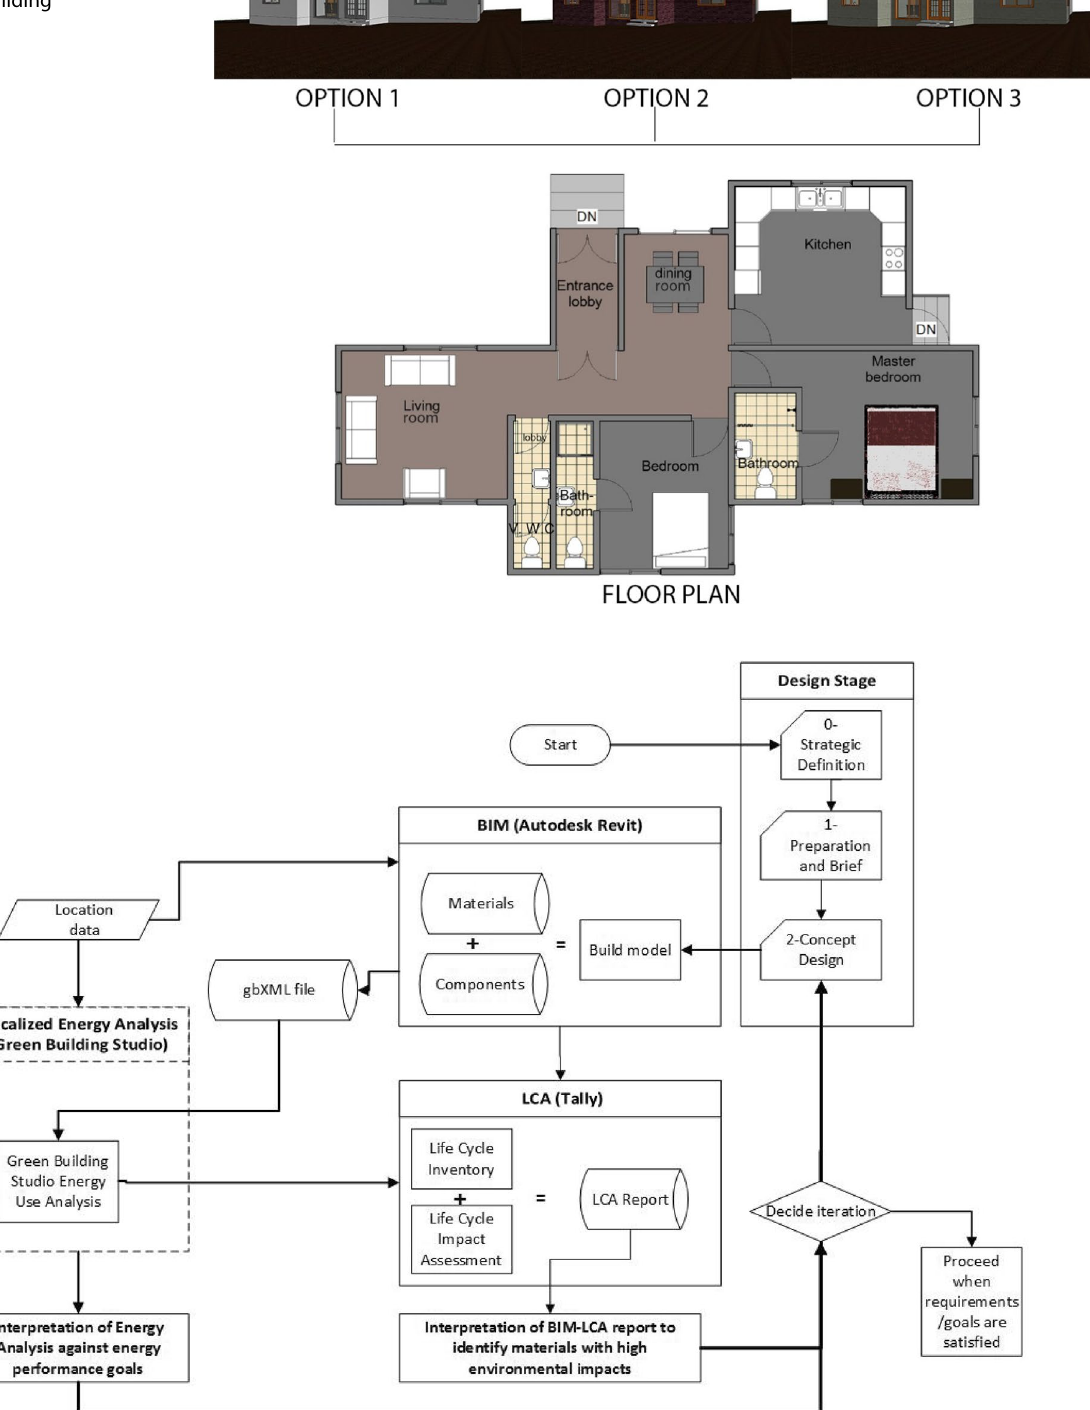
Fig. 4 Layout and 3D views showing design options of case study building